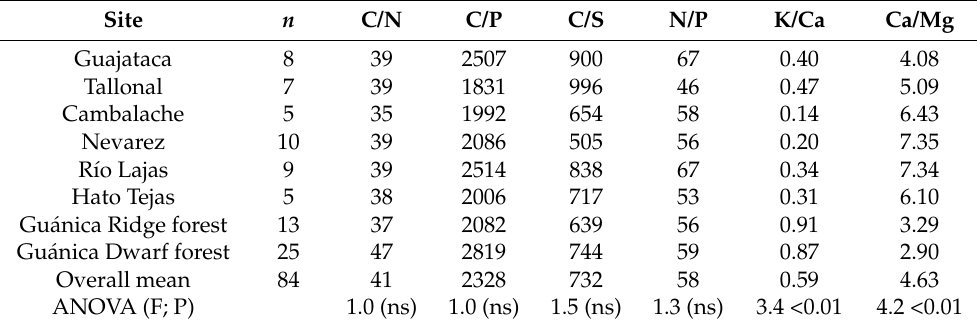
Table 6. Molar elemental ratios of leaves from trees on calcareous